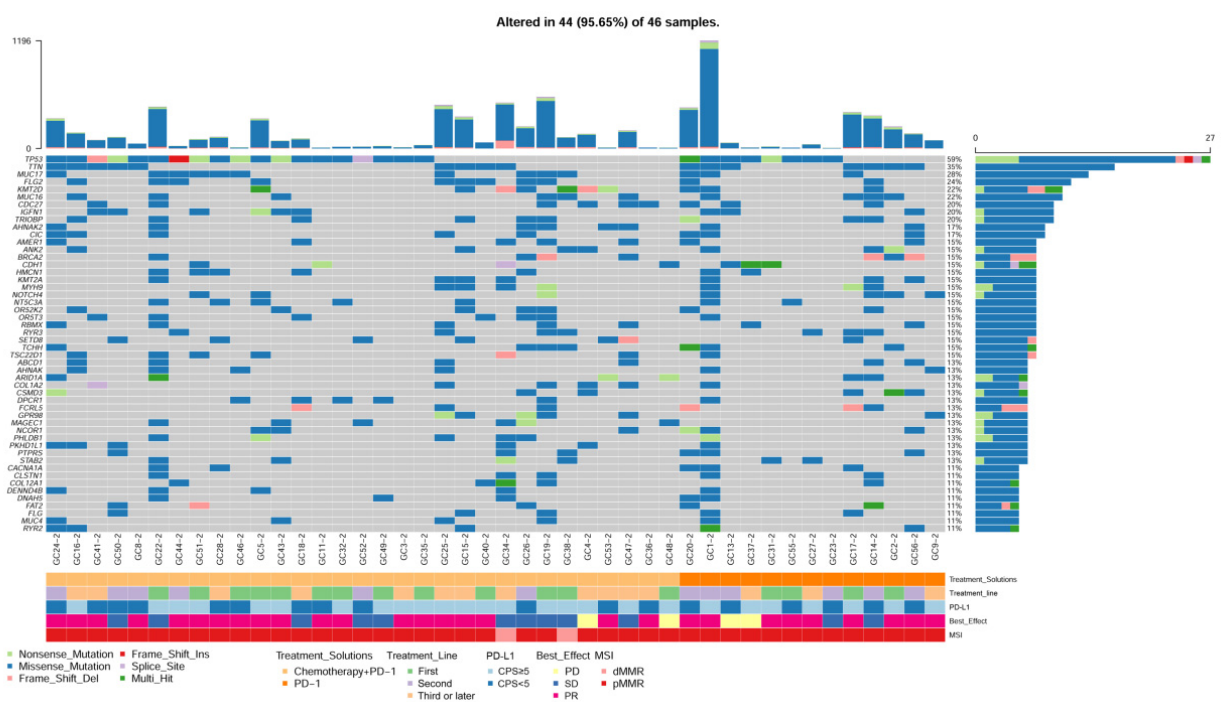
Figure 1. Genomic landscape of gastric Signet ring cell carcinoma (SRCC) The most frequently mutated genes of 46 primary tumor tissues.